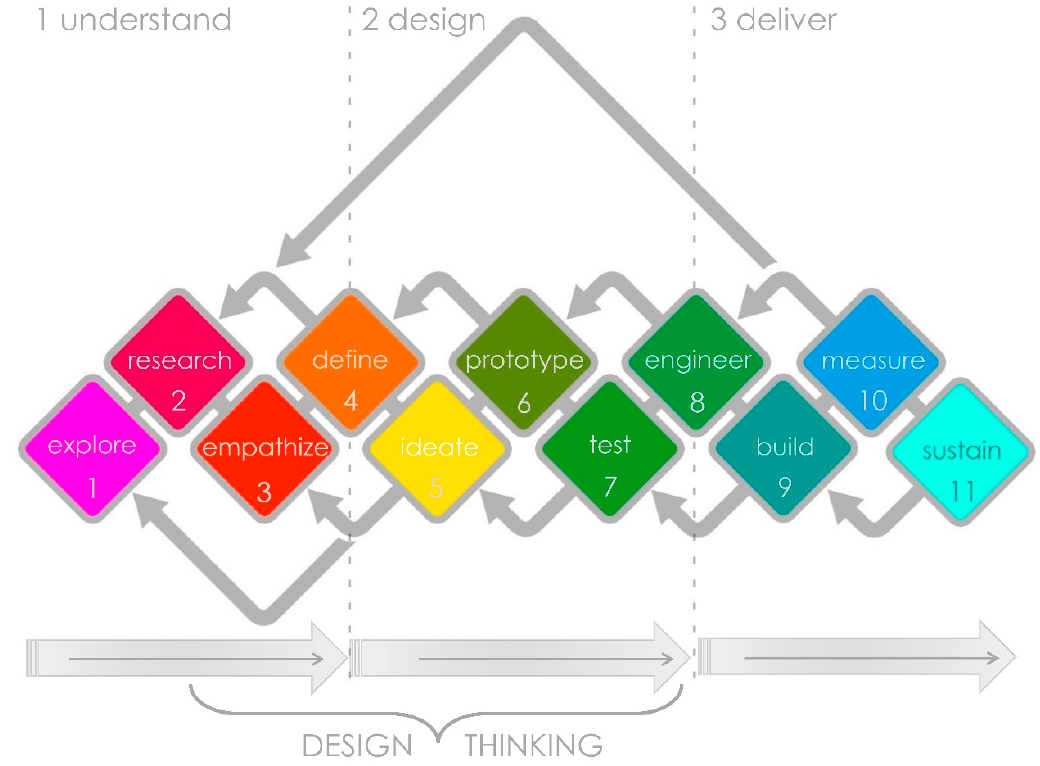
Figure 5. Flowchart of the design and construction method based on user research.